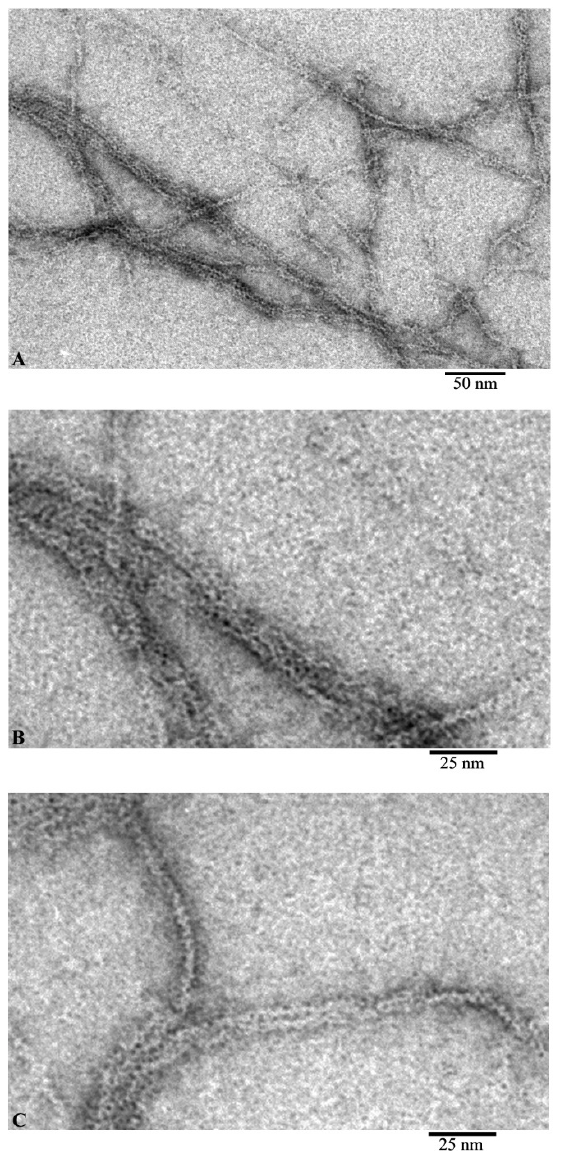
Figure 2. Images of F-actin obtained by electron microscopy. Field ( A ) and fragments of fields of actin filaments: fragments of filaments during adsorption onto the film by the front sides ( B ) and by the side surfaces of actin molecules ( C ).